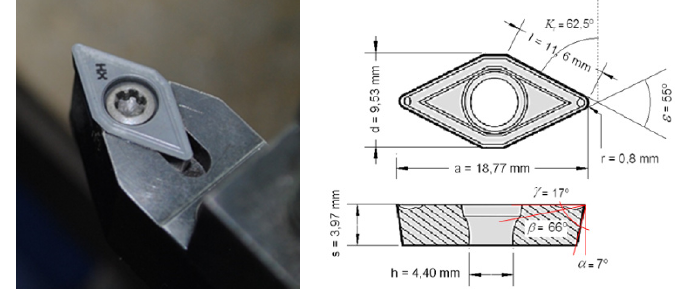
Figure 2. Tool geometry and dimensions. Table 2. Cutting angles setup.